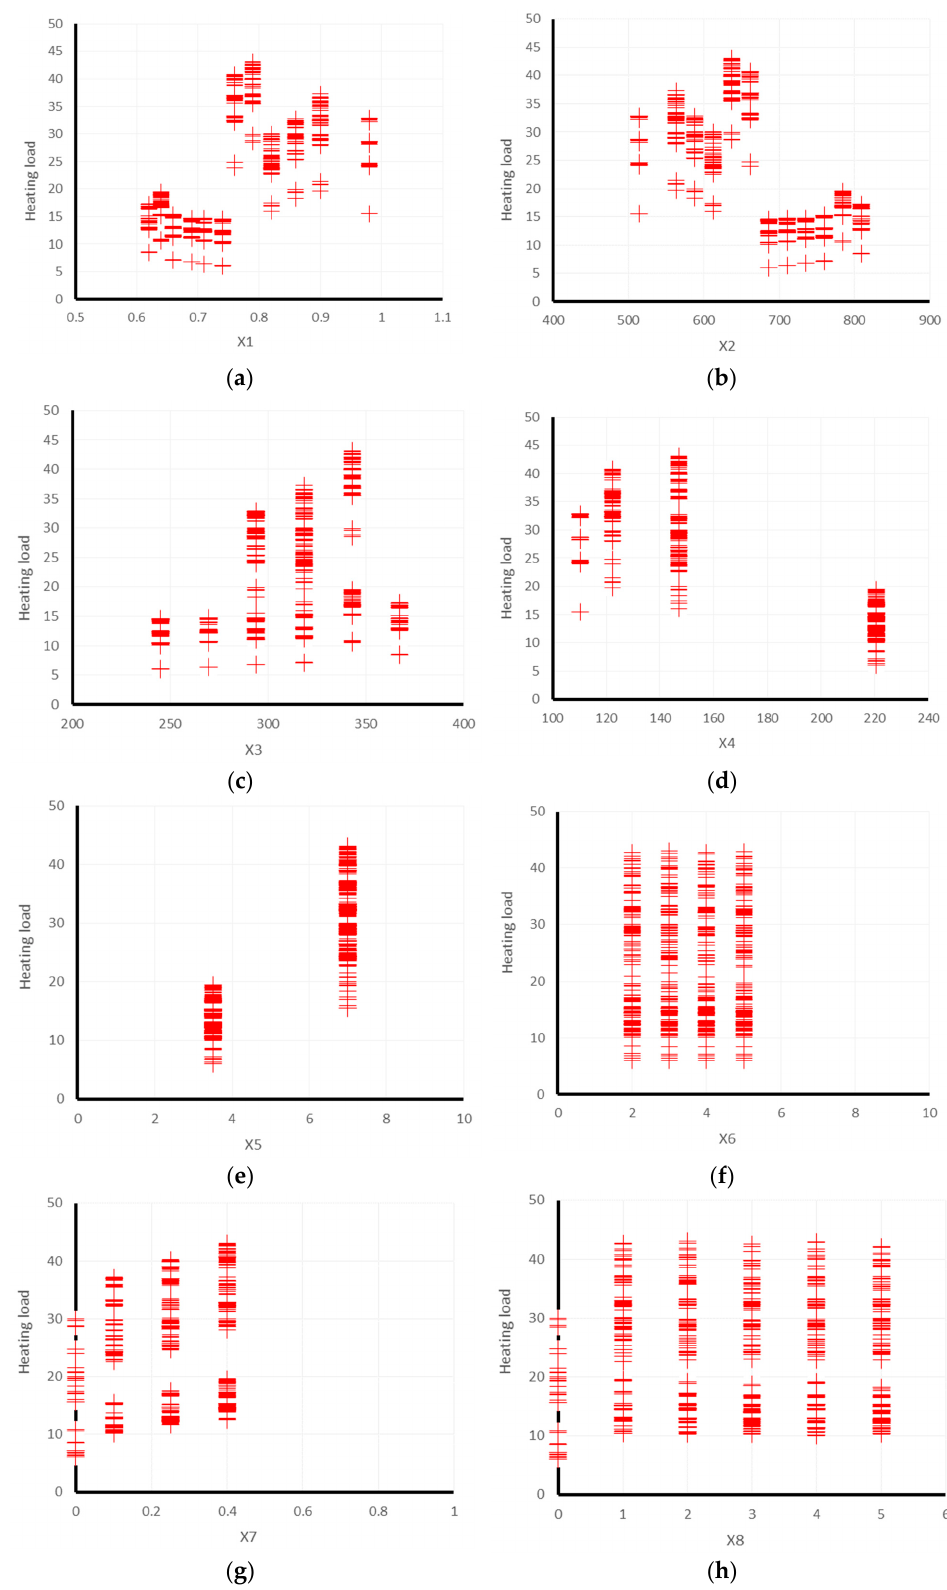
Figure 2. Schematic view of some of the input data layers (X 1 –X 8 as shown in Table 1) in predicting heating load. ( a ) X 1 (Relative Compactness); ( b ) X 2 (Surface Area); ( c ) X 3 (Wall Area); ( d ) X 4 (Roof Area); ( e ) X 5 (Overall Height); ( f ) X 6 (Orientation); ( g ) X 7 (Glazing Area); ( h ) X 8 (Glazing Area Distribution).